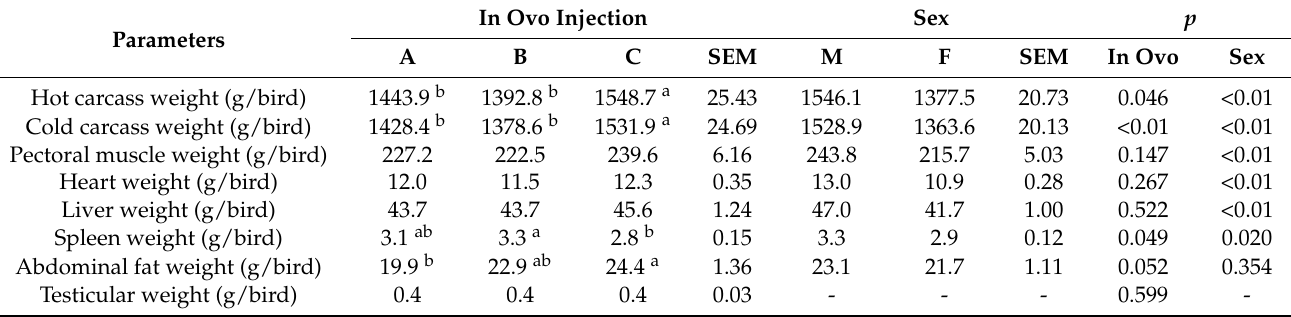
Table 6. The effects of in ovo injection of vitamin C and sex on carcass and internal organ weights of broiler chicks at market age (day